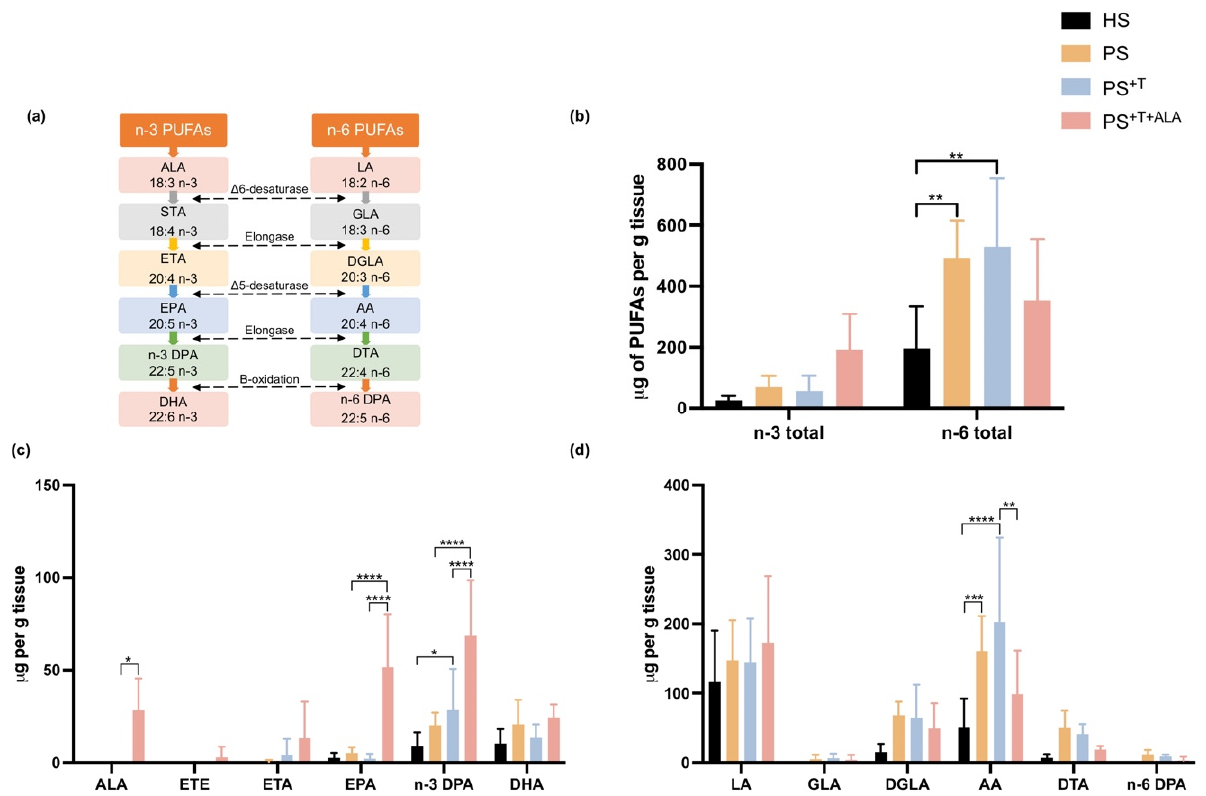
Figure 3. PUFA incorporation into the phospholipid fraction of the epidermis of skin substitutes. Effects of supplementation with ALA and T on the levels of n-3 and n-6 PUFAs in the epidermal phospholipids of HS, PS, PS +T and PS +T+ALA . ( a ) Metabolic pathways of n-3 and n-6 PUFAs; ( b ) Total levels of n-3 and n-6 PUFAs in skin substitutes; ( c ) n-3 PUFA levels in the epidermal phospholipids of skin substitutes; ( d ) n-6 PUFA levels in the epidermal phospholipids of skin substitutes. PUFAs were quantified by gas chromatography and results are presented as μ g per g of tissue. (N = 3 do- nors, n = 2 skin substitutes per donor). Statistical significance was determined using two-way ANOVA followed by Tukey’s post hoc test. Significant differences are indicated by asterisks (* p < 0.05; ** p < 0.01; *** p < 0.001, **** p < 0.0001). Abbreviations: AA: arachidonic acid; ALA: alpha-